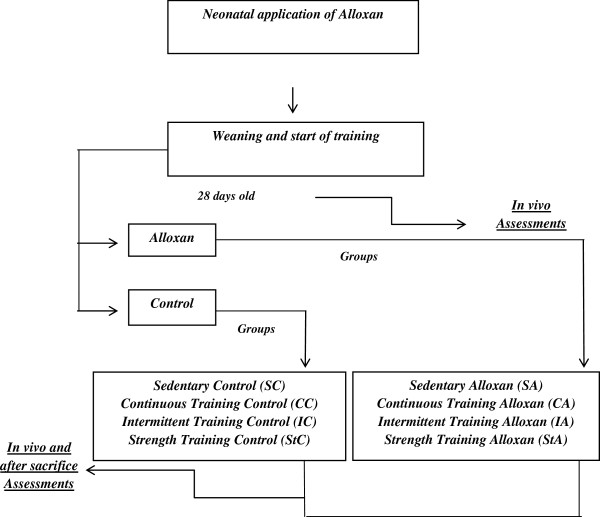
Experimental design.